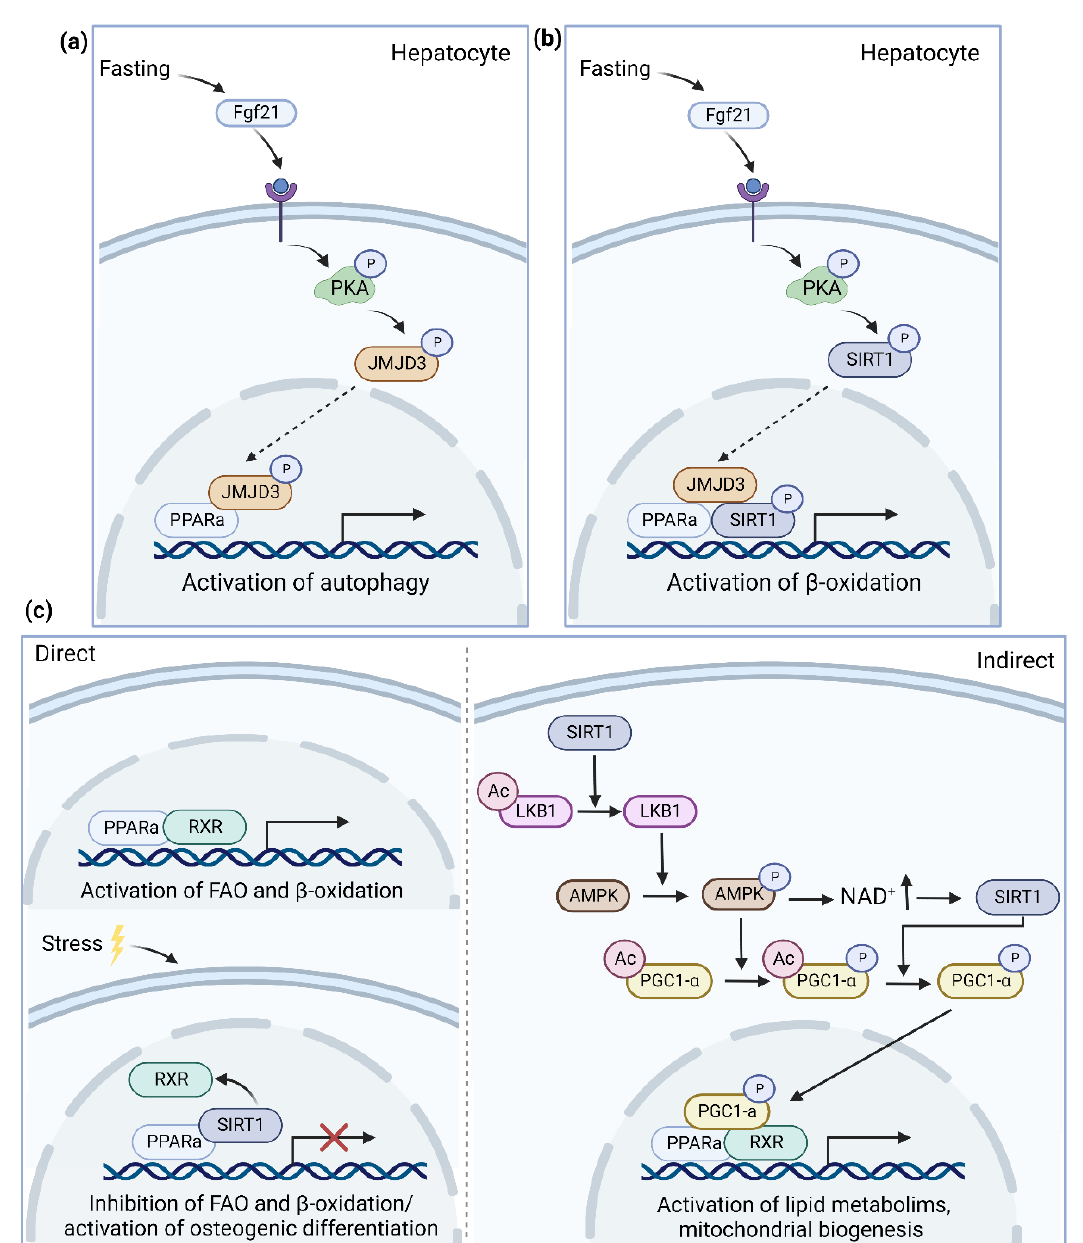
Figure 2. Overview of possible pathways leading to a direct interaction of PPAR α with histone- modifying enzymes regulating diverse pathways. ( a ) JMJD3 can activate autophagy under starvation by interacting with PPAR α ( b ) PPAR α has been described to recruit both JMJD3 and SIRT1 to activate β -oxidation genes under fasting conditions ( c ) It is not clear yet if the bidirectional regulation of PPAR α and SIRT1 target genes is regulated by the direct interaction between PPAR α and SIRT1 or the indirect interaction via the deacetylation of PCG1- α . Abbreviations: peroxisome proliferator-activated receptor- α , PPAR α ; Fibroblast growth factor 21, Fgf21; Protein kinase A, PKA; Jumonji D3, JMJD3; Sirtuin 1, SIRT1; retinoid X receptor, RXR; Liver Kinase B1, LKB1; AMP-activated protein kinase, AMPK; Peroxisome proliferator-activated receptor gamma coactivator 1-alpha, PCG1- α